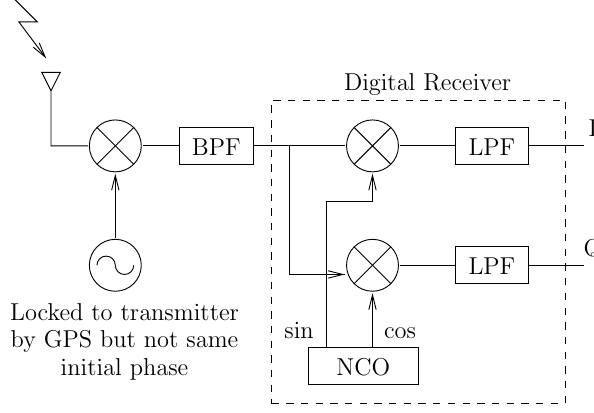
Table 1. Significant radar parameters.